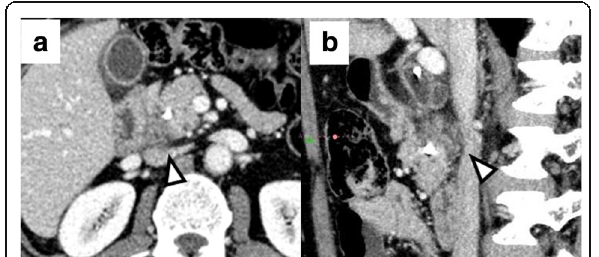
Fig. 5 Preoperative computed tomography (CT) imaging of case 2. a An irregular tumor was identified in the pancreatic head and extended to the dorsal border of the pancreas ( arrowhead ). b Sagittal multi-planar reformation showed that the lesion adhered to and deformed the inferior vena cava (IVC)